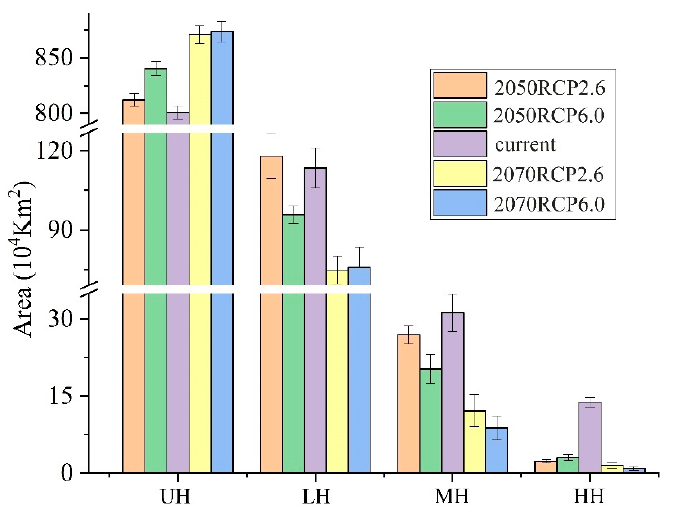
Figure 3. The area of potential suitable habitats over three periods (current, 2050s, and 2070s) under RCP2.6 and RCP6.0 scenarios. UH, LH, MH, and HH represent unsuitable habitat, low suitable habitat, middle suitable habitat, and high suitable habitat, respectively.